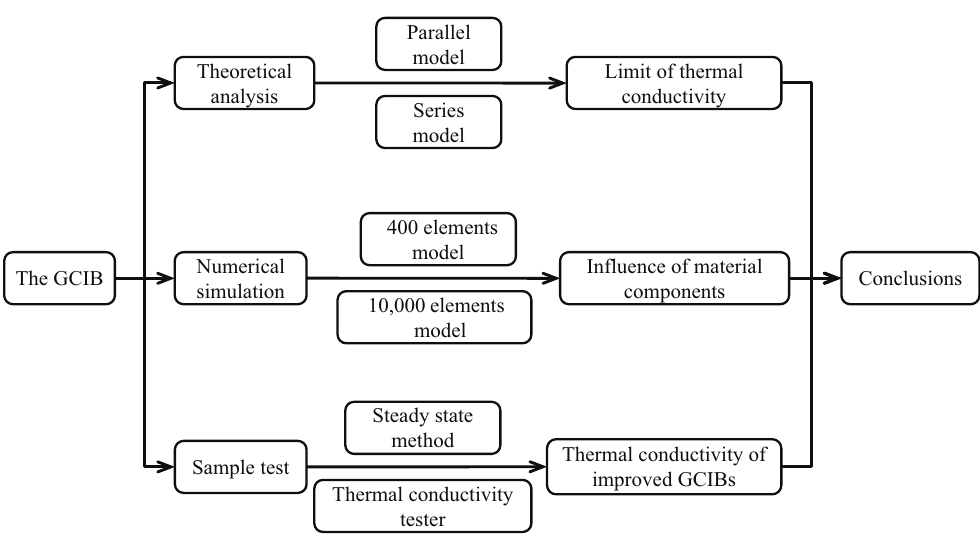
Figure 4. Research technology